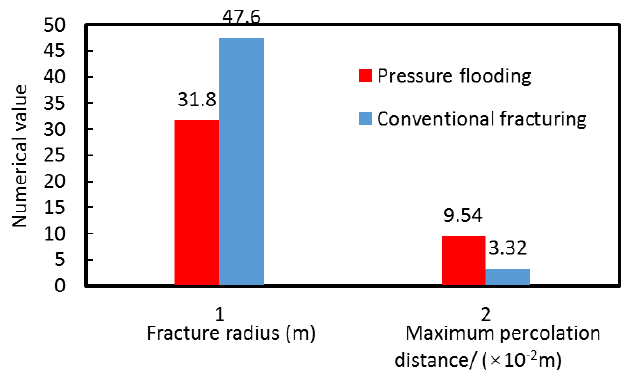
Figure 7. Relationship between pressure and radius in fracture.